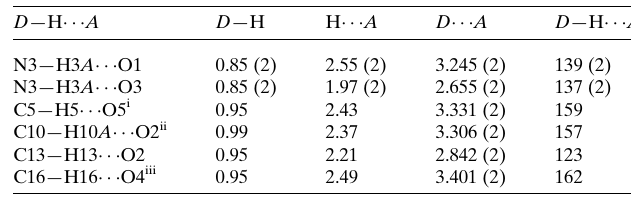
Table 1 Hydrogen-bond geometry (A˚ , (cid:2) ).